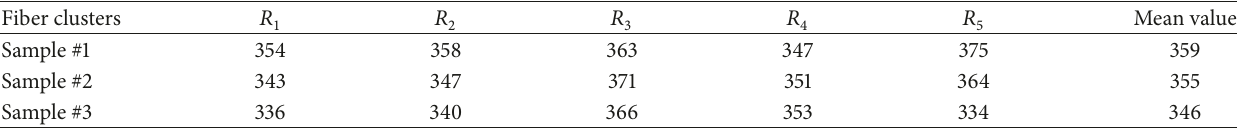
Table 2: The measuring results of R for fibrous clusters (unit: 𝜇